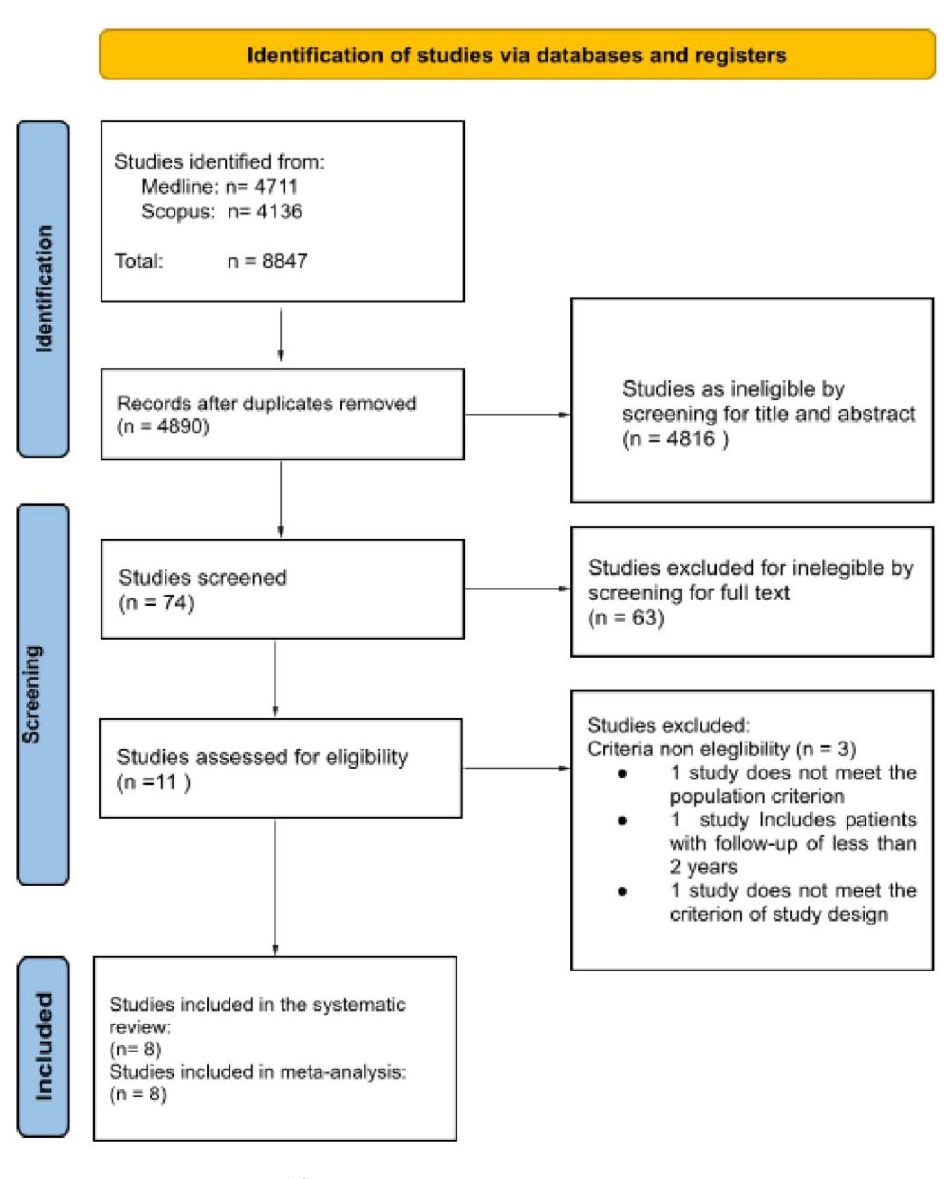
Figure 1. Workflow process.